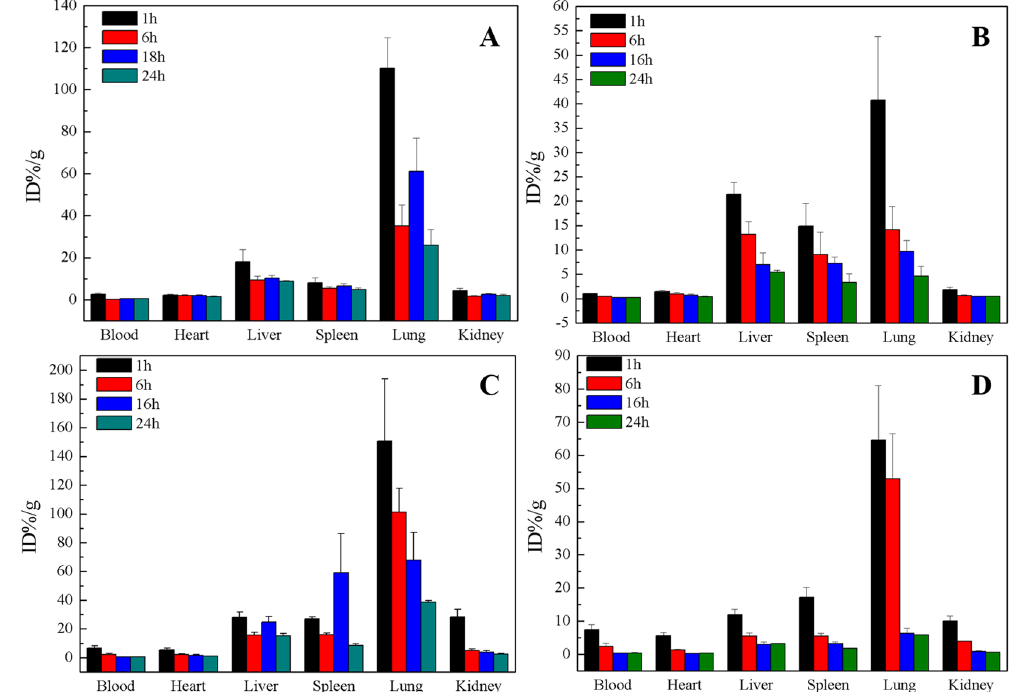
Figure 1. Biodistribution interaction effect of DOPC/or TD on oMWCNTs during 24 h after exposure to mice ( A and B for 131 I-oMWCNTs + DOPC and 131 I-DOPC + oMWCNTs respectively, C and D for 131 I-oMWCNTs + TD and 131 I-TD + oMWCNTs, n = 5, +